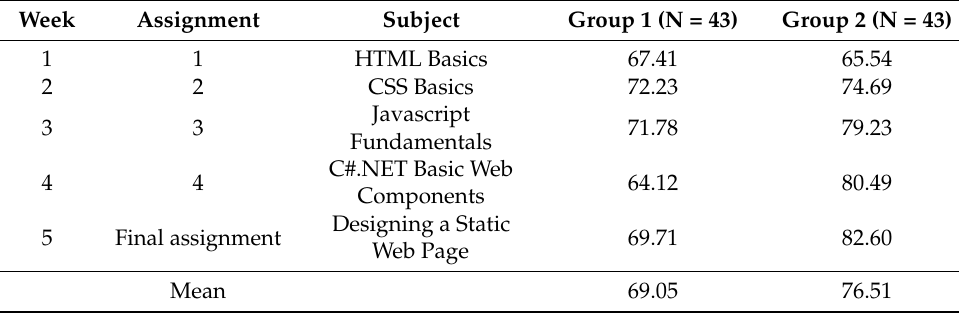
Table 3. Group and week based results of software